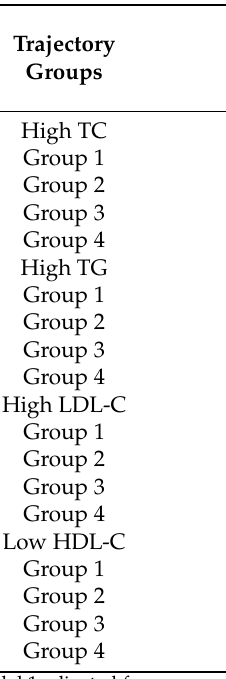
Table 3. Association between the physical activity trajectory groups and odds ratio of